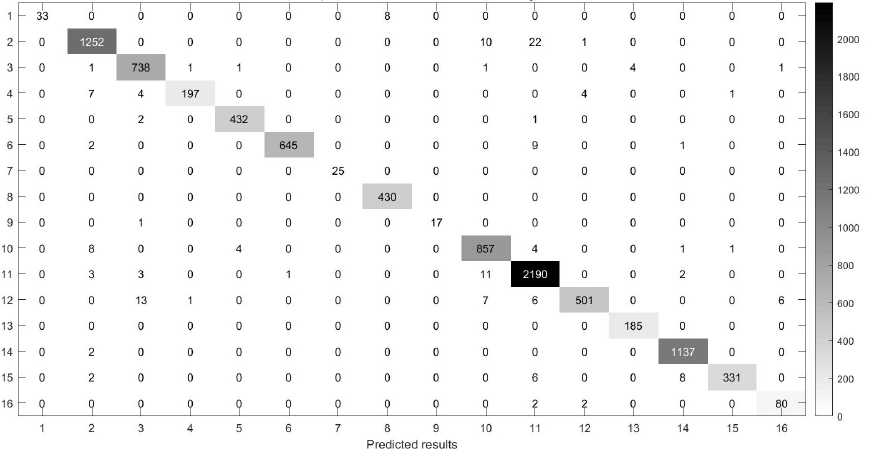
Figure 15. The confusion matrix between the predicted results of MSR-3DCNN and ground truth on the IP dataset using 10% samples for training and ( 9 × 9 ) patch size.